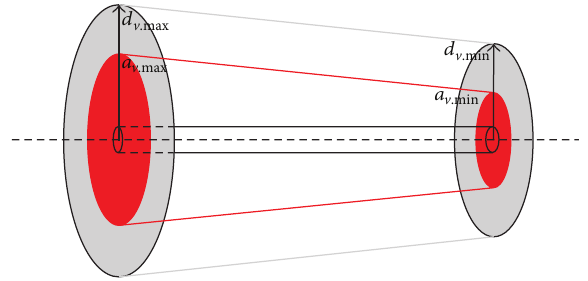
Figure 4: Distribution of DZ and AZ along the